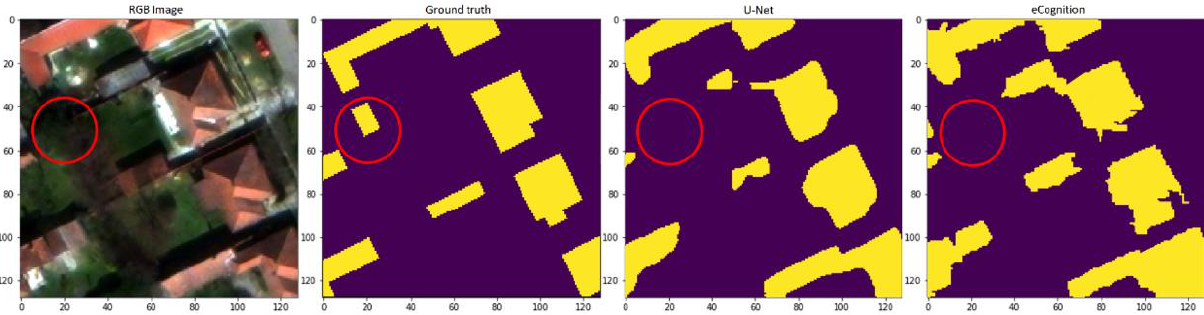
Figure 20. Non-existence of objects that are still registered in the real estate cadastre—Subotica.